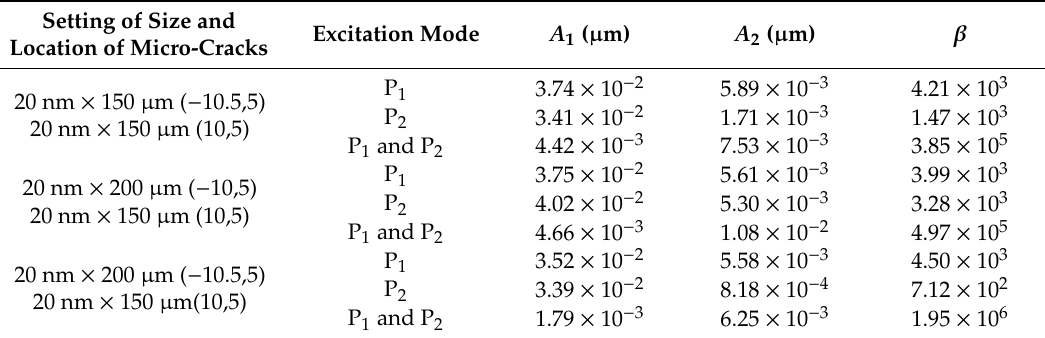
Table 1 . Simulation results of A 1 , A 2 , and β when exciting Rayleigh waves in different modes on the Table 1. Simulation results of A 1 , A 2 , and β when exciting Rayleigh waves in di ff erent modes on the premise of having changing sizes and locations of micro ‐ cracks. premise of having changing sizes and locations of